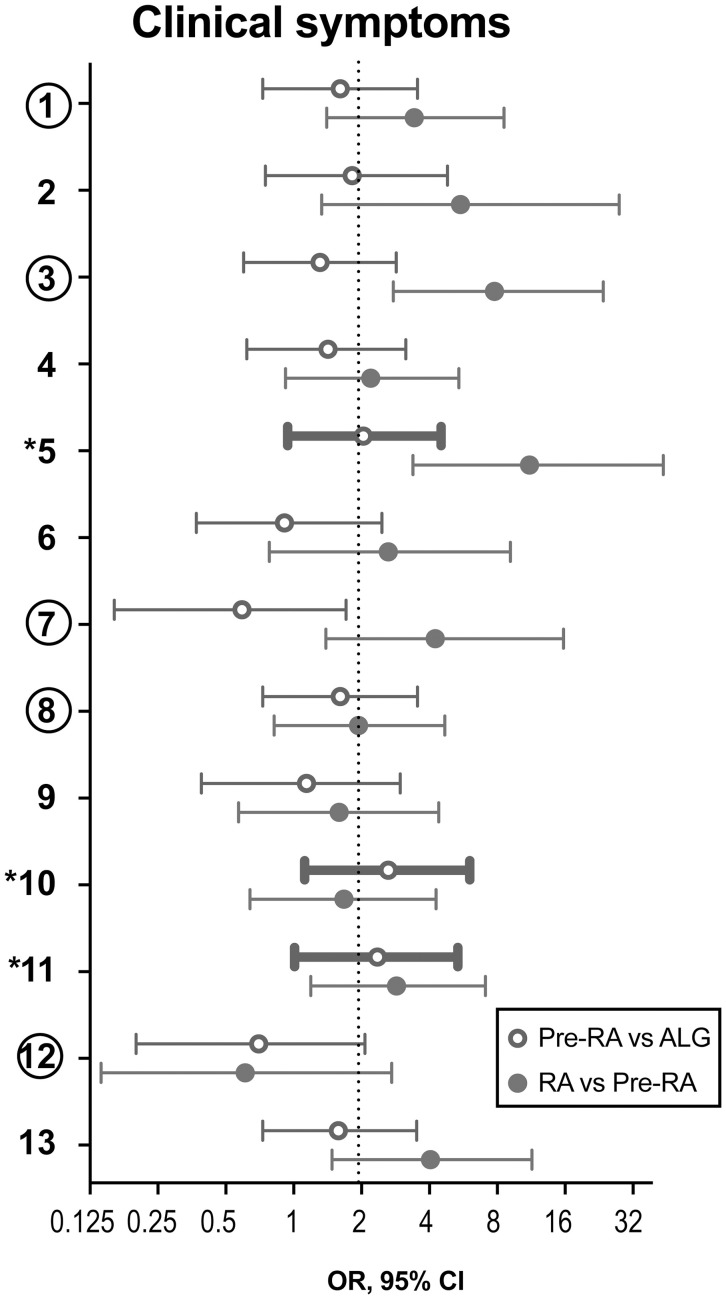
Clinical symptoms to discriminate the pre-RA patients from arthralgia and RA patients. During the prospective follow-up of 180 patients with unexplained arthralgia (ALG), 32 patients developed RA. These patients were considered pre-RA at the time of their first visit. Clinical parameters at the first visit of the pre-RA patients are compared to the remaining ALG patients (n = 148) and with the patients who fulfilled RA diagnosis at the first visit (n = 63). Data are shown as odds ratio (OR) with 95% confidence interval. Comparison between pre-RA and ALG groups is shown with open circles, and between RA and pre-RA groups, is shown with filled circles. Thick lines indicate the parameters with OR>2.0 discriminating pre-RA from ALG. The 3 symptoms marked with asterisk distinguish pre-RA cases. The 5 symptoms marked with circles comprise by consensus the positive definition of arthralgia in progression to RA. (1) Joint symptoms onset <1 year, (2) 4–10 joints with symptoms, (3) Symptoms in MCP joints, (4) Symptoms in MTP joints, (5) Symptoms in several small joint regions, (6) Symmetric symptoms and signs, (7) Duration of morning stiffness >60 min, (8) Most severe symptoms in the early morning, (9) Improvement of symptoms during the day, (10) Increasing number of joints with symptoms over time, (11) Patient experience of swelling of small hand joints, (12) Presence of a first-degree relative with RA, (13) Local tenderness involved joints at physical examination.